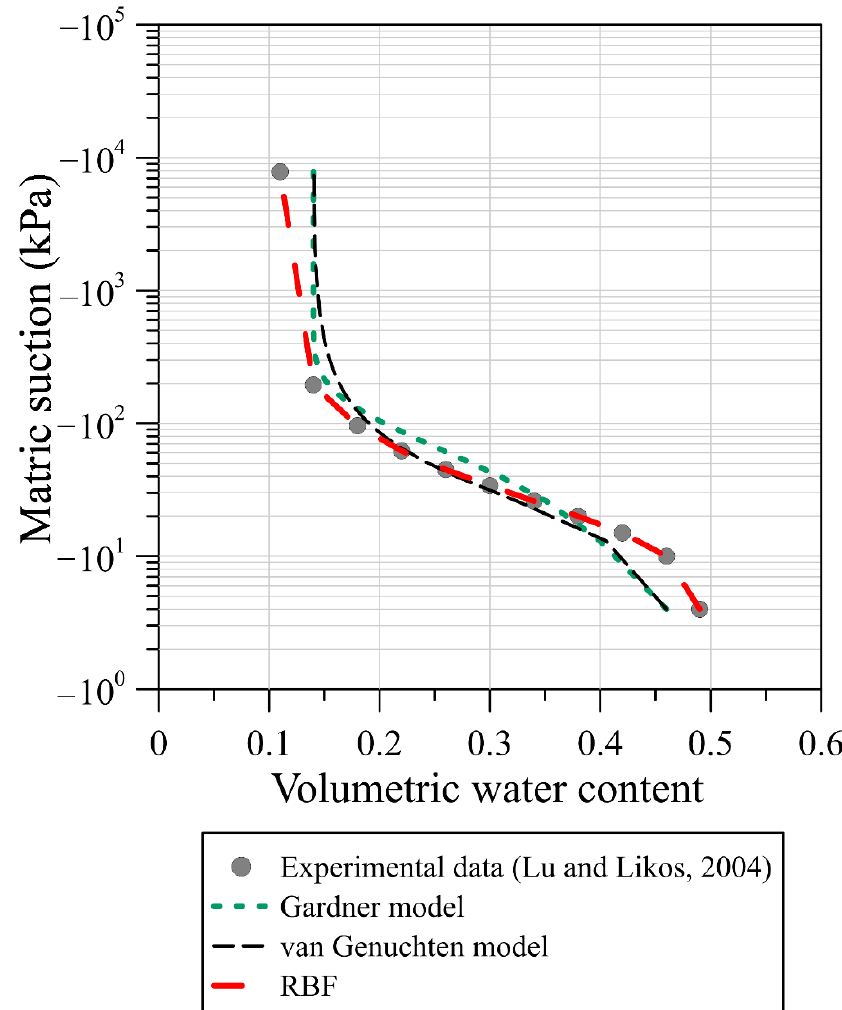
Figure 13. The fitted results of the SWCC (sandy soil).